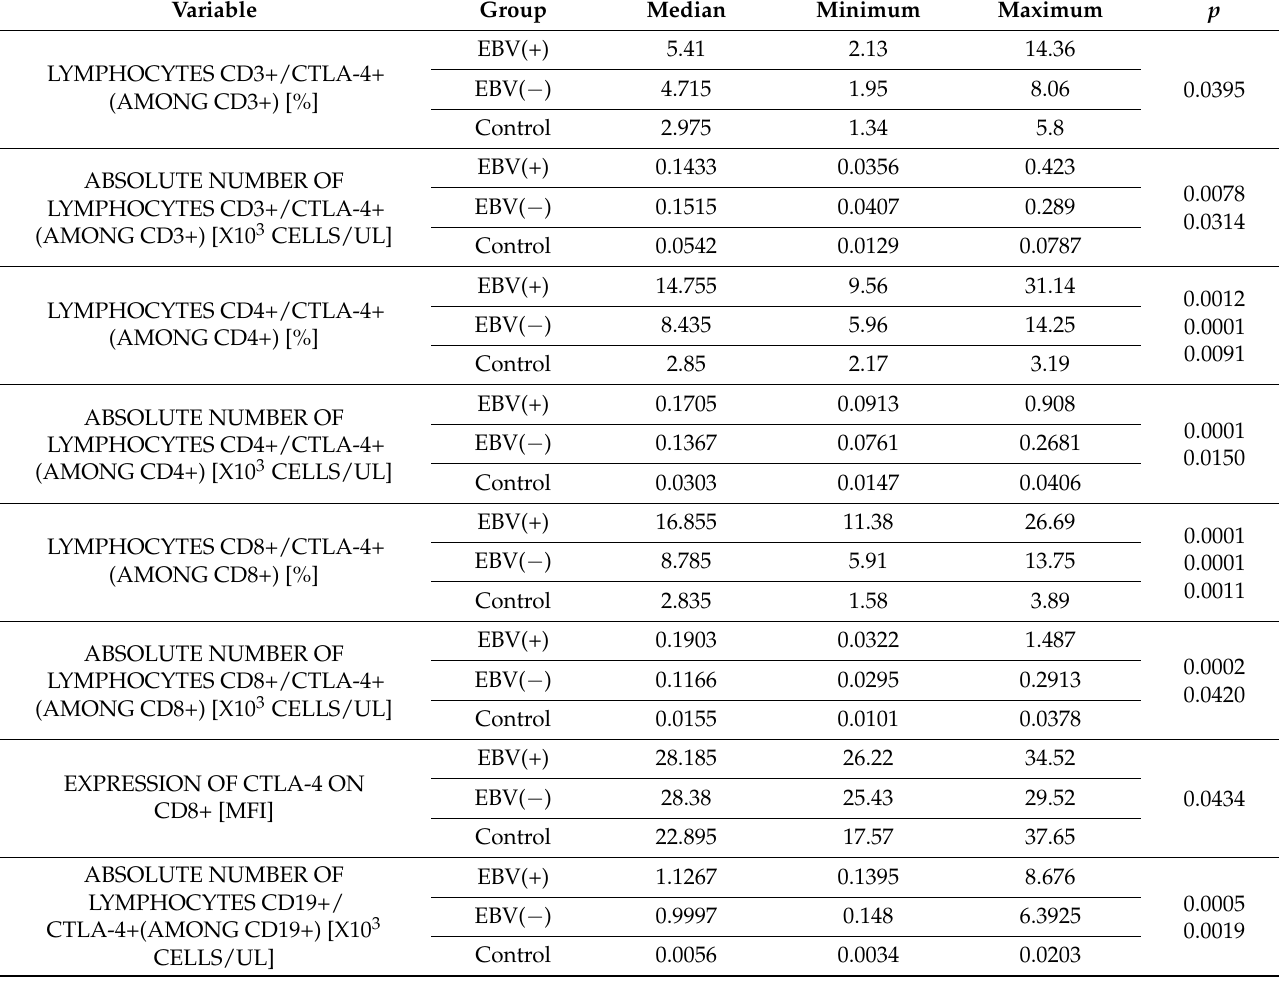
Table 3. CTLA-4 expression in EBV(+) patients with CLL, EBV( − ) patients with CLL and controls.